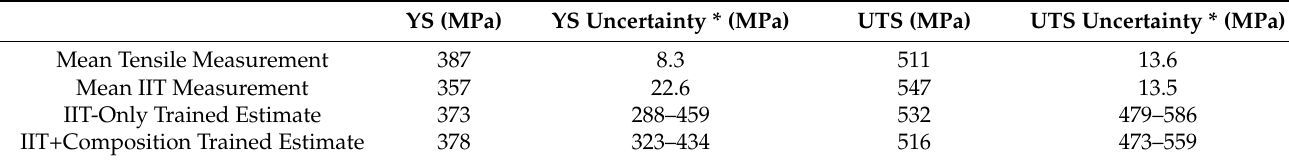
Table 6. YS and UTS estimates based on the regression models presented in Section 3.3, includ- ing corresponding mean tensile and IIT measurements, for the 16-inch (41-cm) OD pipe in the presented